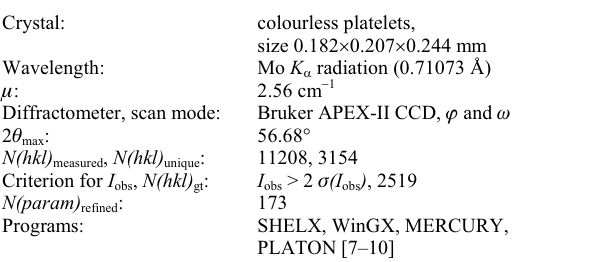
Table 1. Data collection and